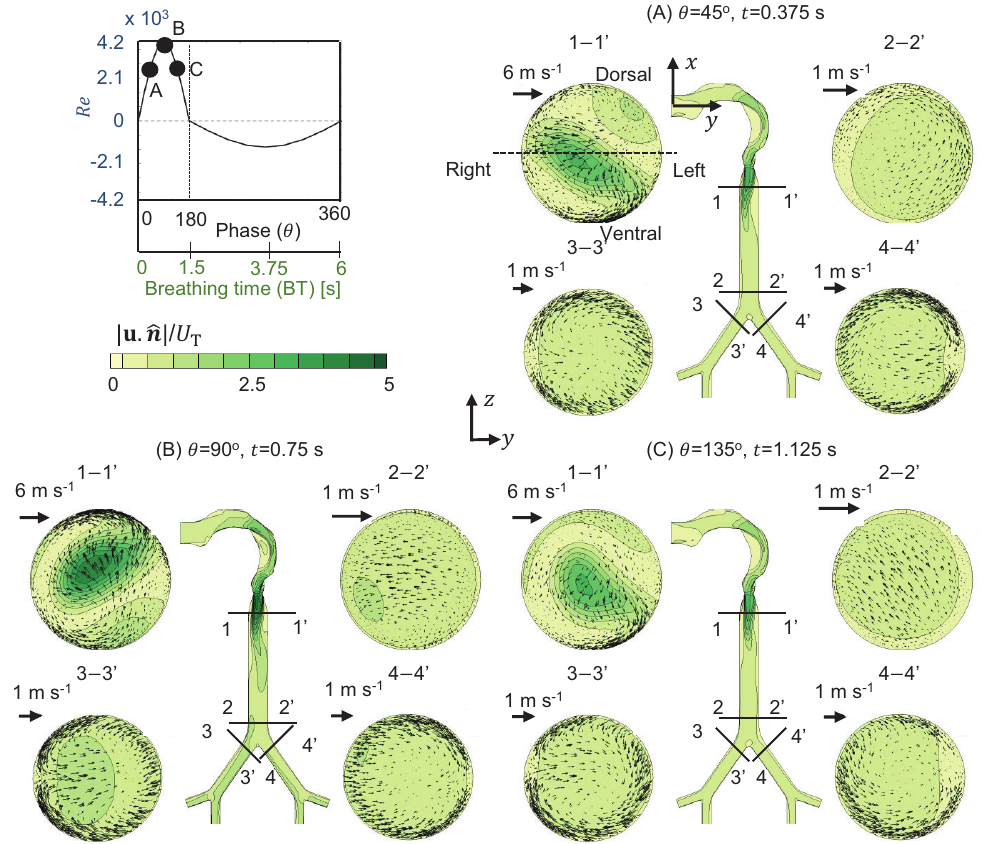
Figure 3. Contours of magnitude of the plane-normal velocity component (non-dimensionalized with mean flow speed in trachea, U T ) with superimposed in-plane velocity vectors for Planes 1–4 at various time-points during inhalation for Wo = 2.41 at IT/BT = 25%. A is at Phase θ = 45 ◦ (=25% IT), B is at Phase θ = 90 ◦ (=50% IT), and C is at Phase θ = 135 ◦ (=75% IT). Views for Plane 3 and Plane 4 were rotated at 35 ◦ and − 35 ◦ , respectively, viewed perpendicular to each plane. The reference vector for in-plane velocity components is shown for each